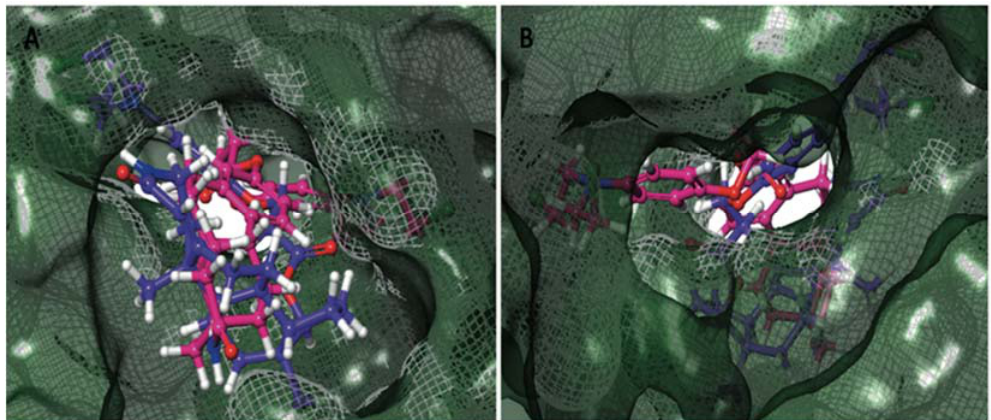
Figure 10. ( A ) Front side and ( B ) Backside of the active site cavity of AKT1 (PDB ID 4EJN) with hybrid molecules ENGA-L06E and ENGA-L08E docked and superimposition of calculated molecules ENGA-L06E and ENGA-L08E given in purple and pink colored carbons, respectively.